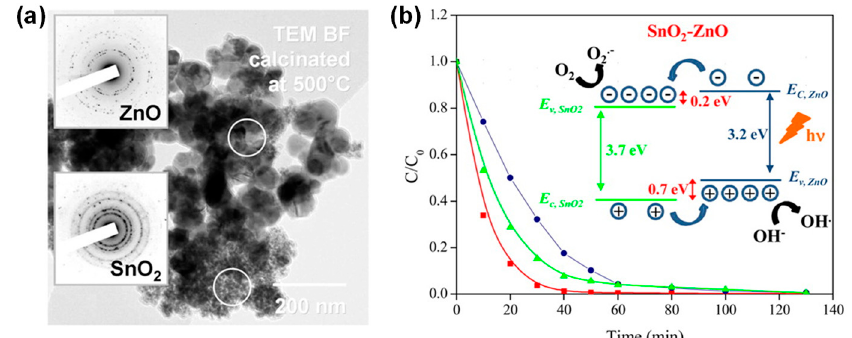
Figure 10. ( a ) Nanostructures of SnO 2 − ZnO composite photocatalysts. ( b ) The corresponding photocatalytic performances of SnO 2 –ZnO (red line with square dots), SnO 2 (green line with triangle dots), and ZnO (blue line with circle dots). Adapted with permission from Reference [63]. Copyright (2012) American Chemical Society.